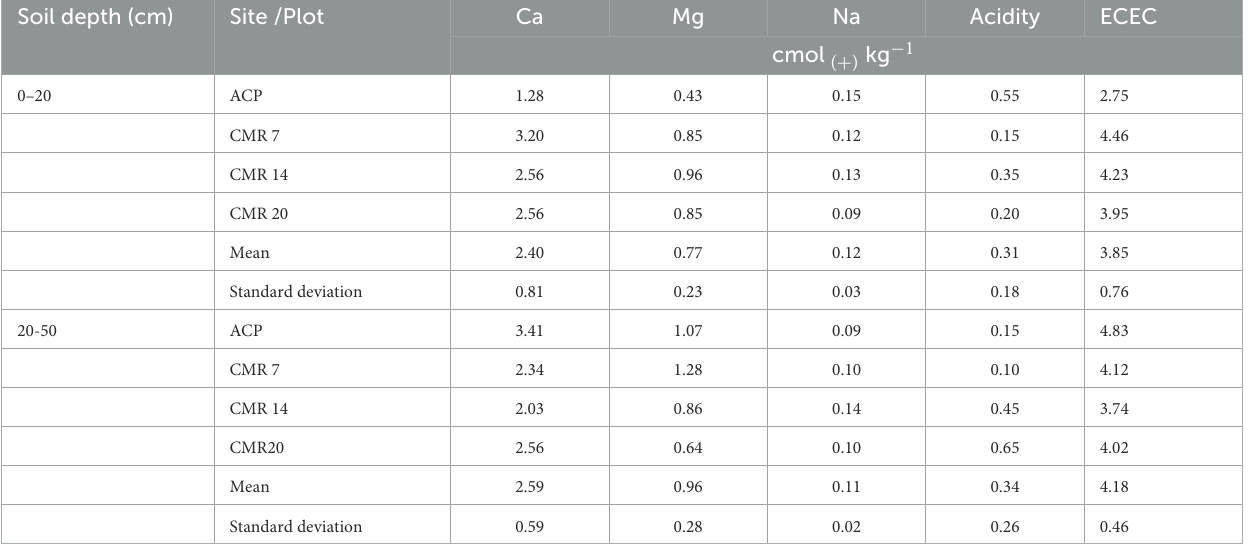
TABLE 4 Exchangeable bases, acidity and ECEC levels under various cropping systems.